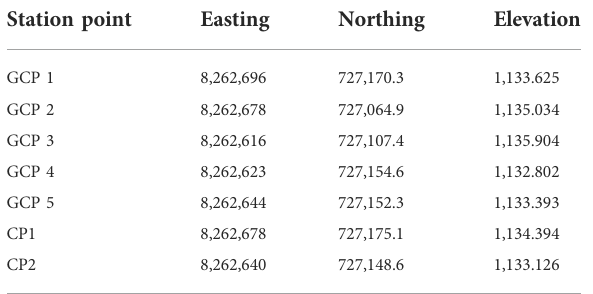
TABLE 3 Ground control and checkpoints coordinates.